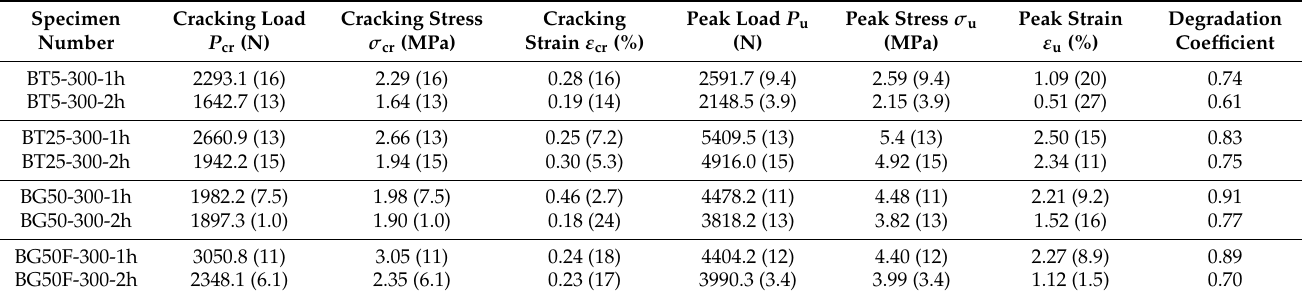
Table 4. Tensile test results of the BGRM after exposure to elevated temperature.